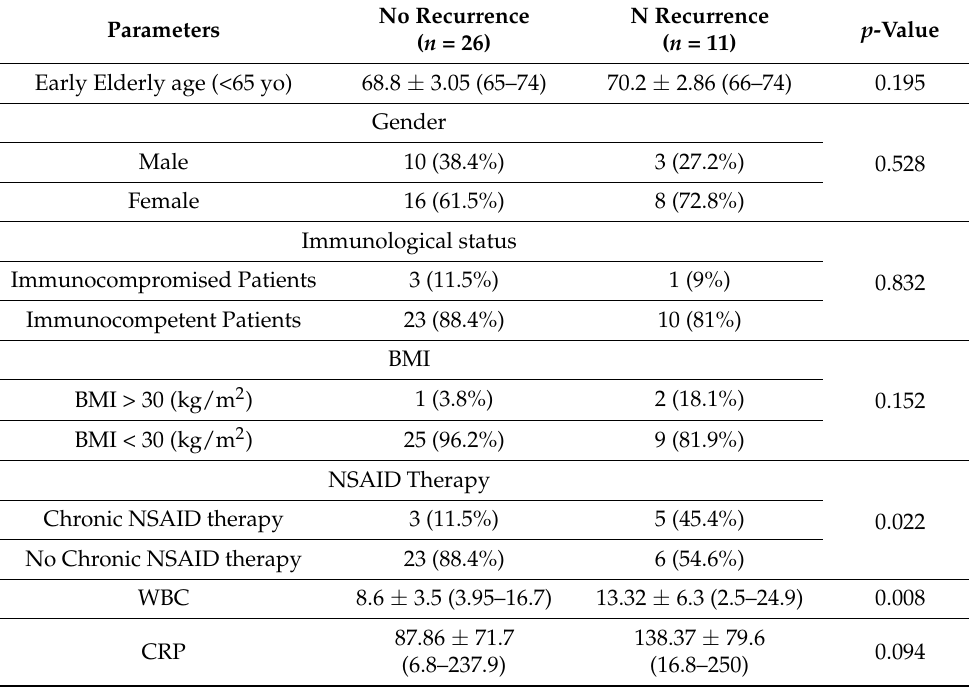
Table 3. Clinical characteristics of early elderly patients with and without recurrence.